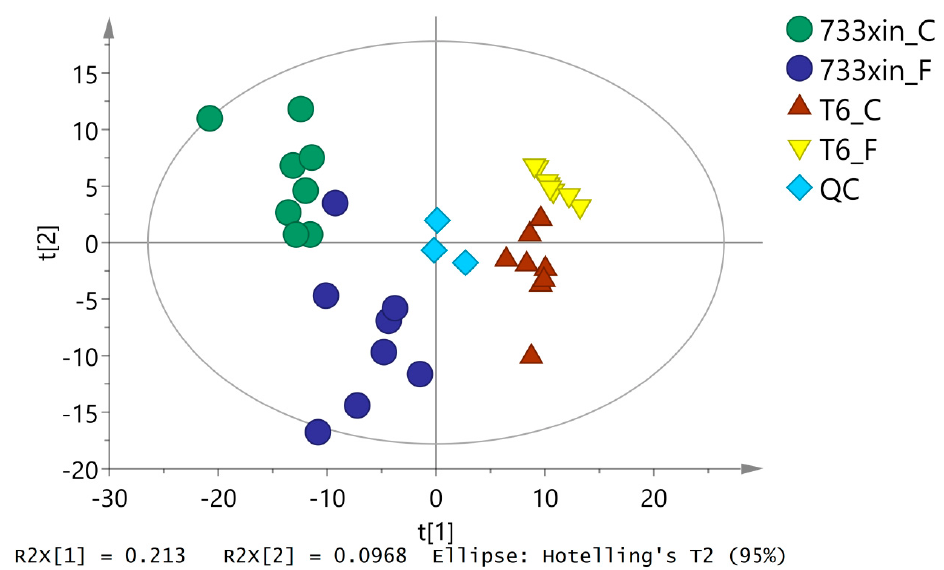
Figure 1. PCA score plots based on the GS-MS data of the Bombyx mori midgut samples.